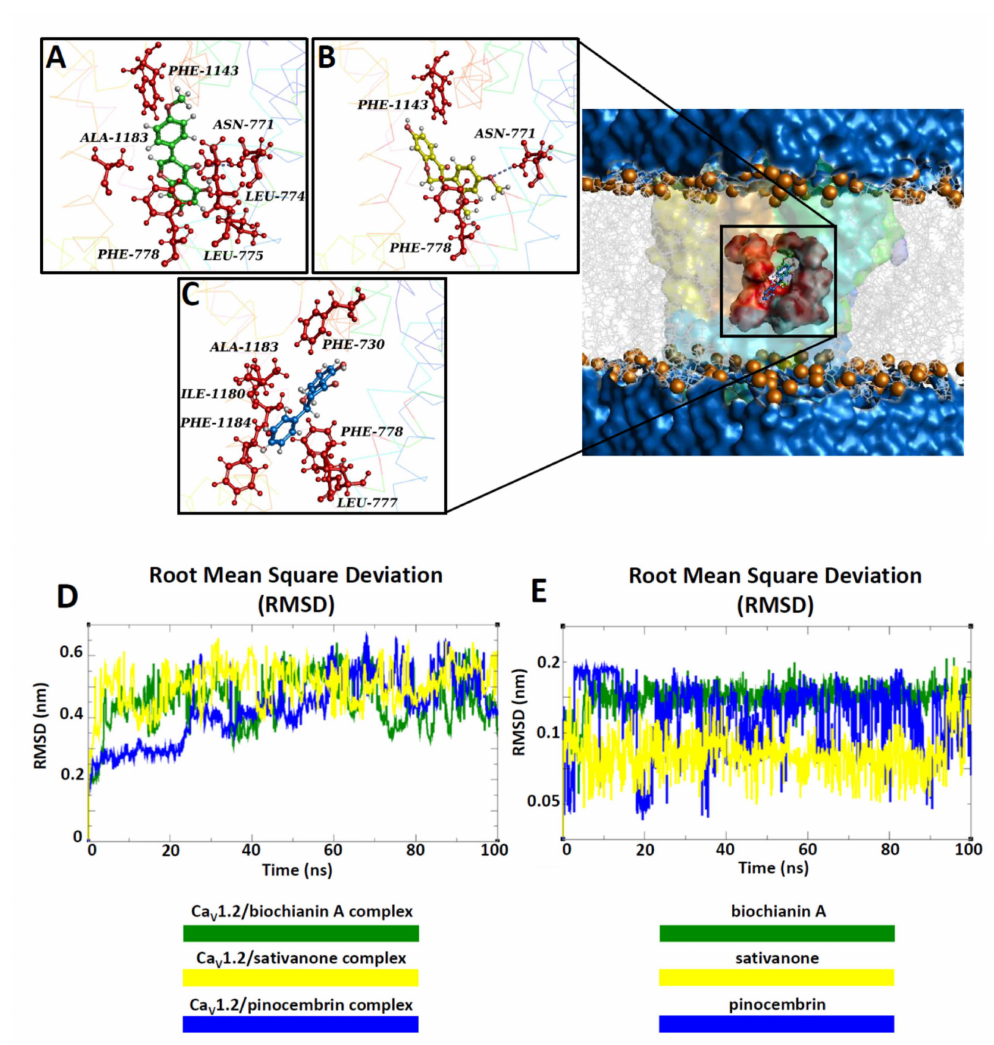
Figure 7. Overview of the Ca V 1.2 channel docked with biochanin A, sativanone, and pinocembrin. The Ca V 1.2 channel’s 3D structure is depicted with a multicolour transparent surface, while the binding pocket is reported in red. The bilayer is represented by grey lines, and some phospholipid heads are shown as orange spheres. The extracellular and cytoplasmatic side is shown as a blue surface. ( A – C ) Interaction network of ( A ) biochanin A, ( B ) sativanone, and ( C ) pinocembrin in complex with the Ca V 1.2 binding residues (i.e., red balls and sticks) after the docking simulation. The hydrogen bond is represented as a purple dotted line. ( D , E ) Root mean square deviation (RMSD) profiles of biochanin A, pinocembrin, and sativanone. ( D ) RMSD profiles of the Ca V 1.2 channel backbone in complex with biochanin A, pinocembrin, and sativanone. ( E ) RMSD profiles of the biochanin A, pinocembrin, and sativanone binding pose in complex with the Ca V 1.2 channel. The RMSD trends are represented as coloured lines (see legend). RMSD (nm) and time (ns) values of the MD run are reported on the y - and x -axis,